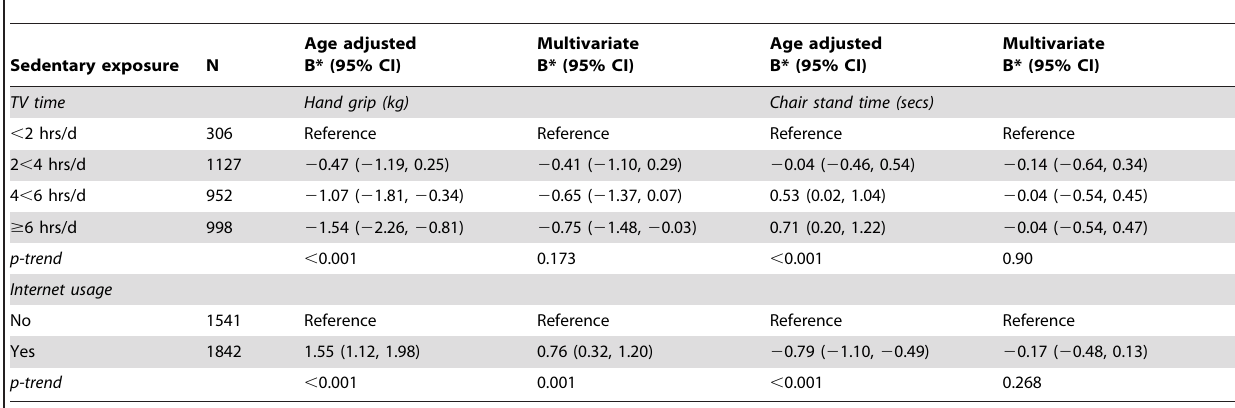
Table 3. The association between TV time, internet use and muscle strength in women (N =3383).